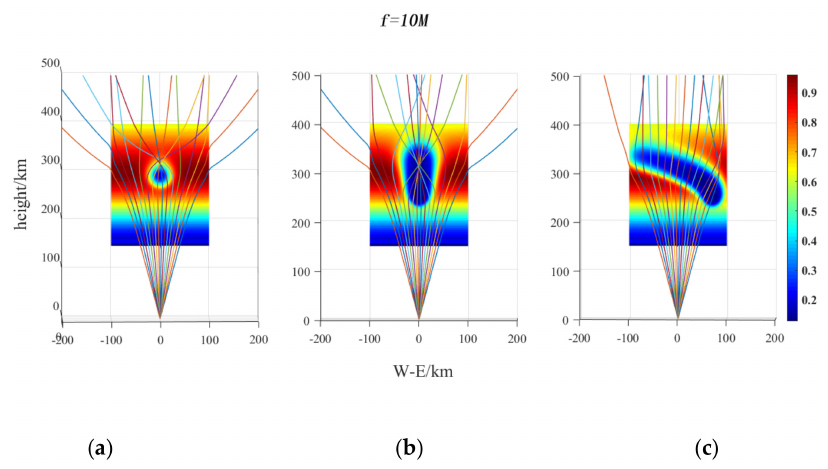
Figure 10. 3D ray-tracing simulation of 10 MHz short wave propagation path after 100 s of H 2 O re- leased by rocket under different flight paths (electron density unit: 10 6 cm − 3 ); ( a ) 300 km fixed − point